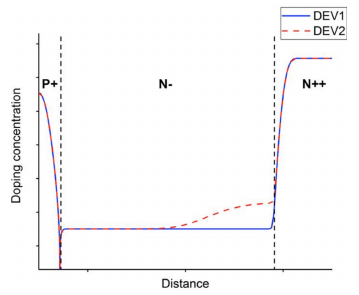
Figure 4. A sketch of the DEV1 and DEV2 doping profiles. The doping type is specified for the three main